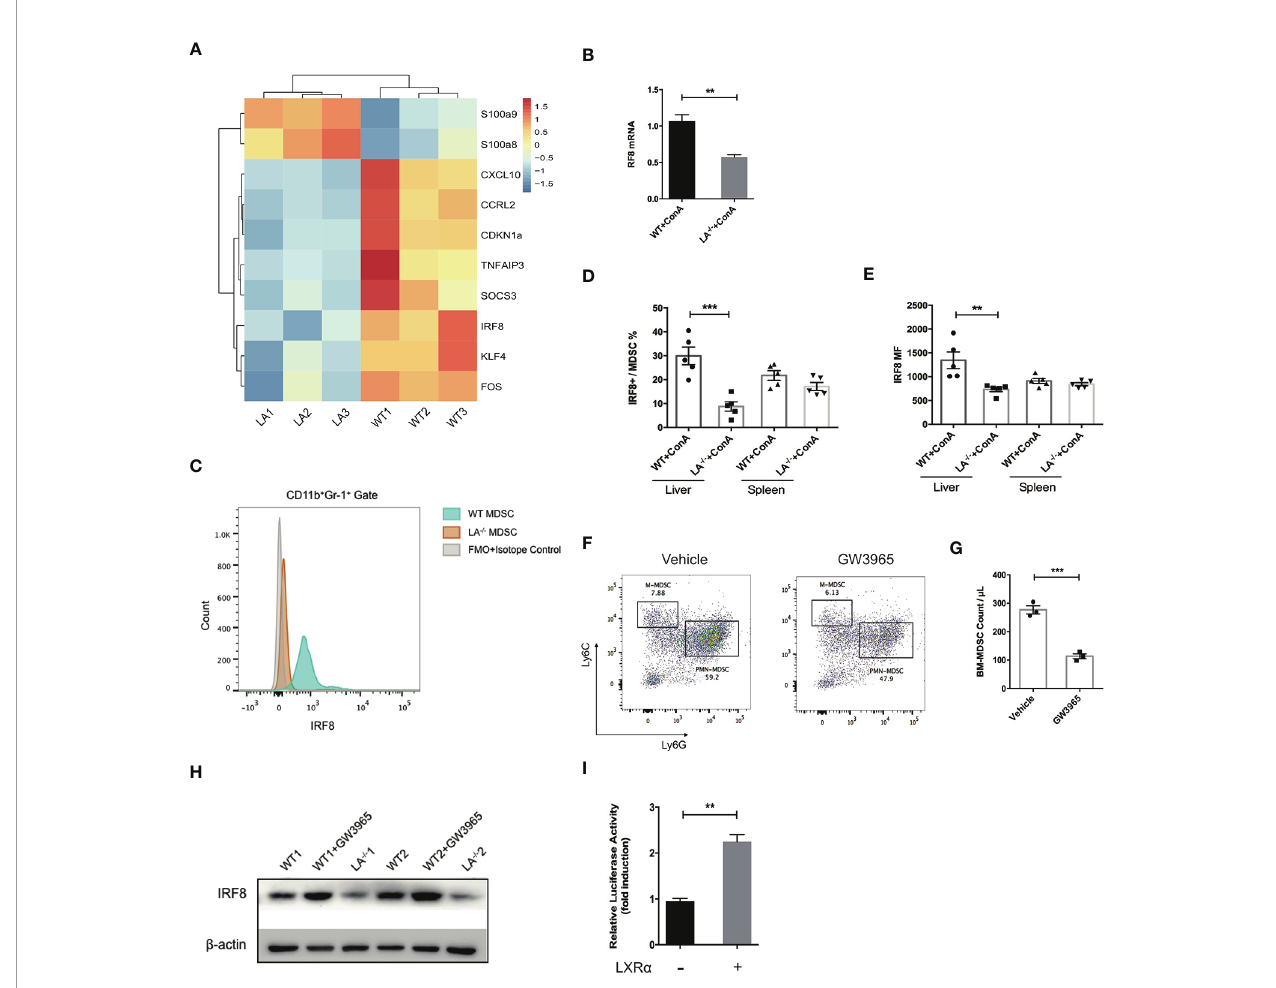
FIGURE 5 | LXR a activation induced IRF-8 expression and hampered the differentiation of MDSCs. (A) MDSCs puri fi ed from bone marrow of WT and LXR a − / − mice treated with ConA ( n = 3 per group) were subjected for transcriptional sequencing. Shown are the representative differential genes. IRF-8 was downregulated in MDSCs of LXR a − / − mice. (B) Validation of IRF-8 expression in MDSCs from WT and LXR a − / − mice by real-time PCR. (C – E) Protein expressions of IRF-8 in hepatic MDSCs were con fi rmed by fl ow cytometry. (F, G) Induction of MDSCs from bone marrow cells using GM-CSF and IL-6 for 4 days. BM-derived MDSCs were reduced signi fi cantly by treatment of GW3965. (H) BM-derived MDSCs from WT and LXR a − / − mice, and WT mice treated with GW3965 were analyzed for IRF-8 expression by Western blot. (I) The IRF-8 promoter luciferase activity with or without overexpression of LXR a after 48-h transfection in HEK293T cells. The experiment has been repeated for three times. Data are presented as mean ± SEM. ** p < 0.01, *** p <